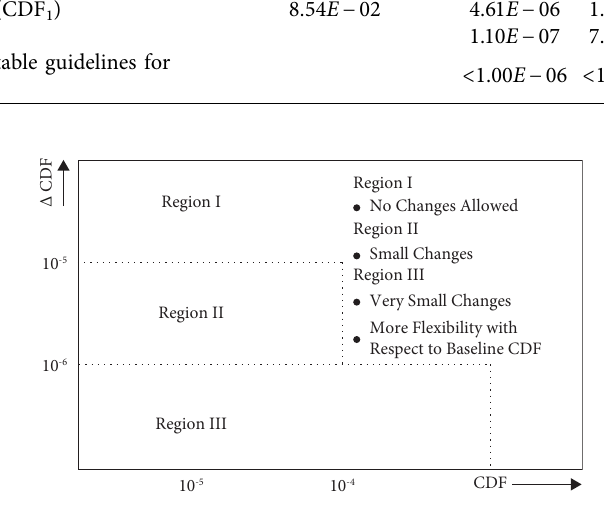
Figure 5: Risk-acceptance criteria in RG1.174.